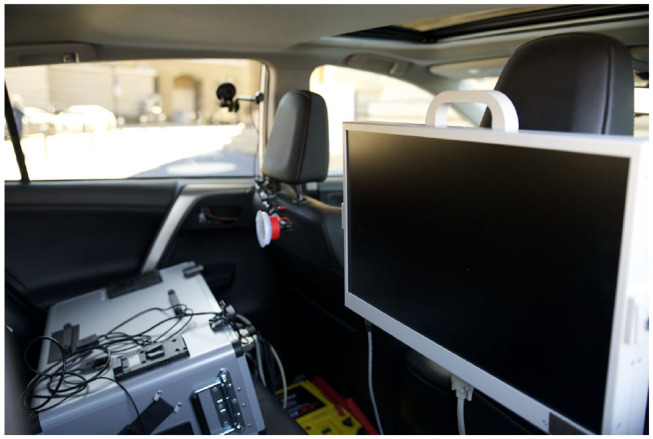
Data collection computer and monitor in the backseat of the instrumented vehicle.